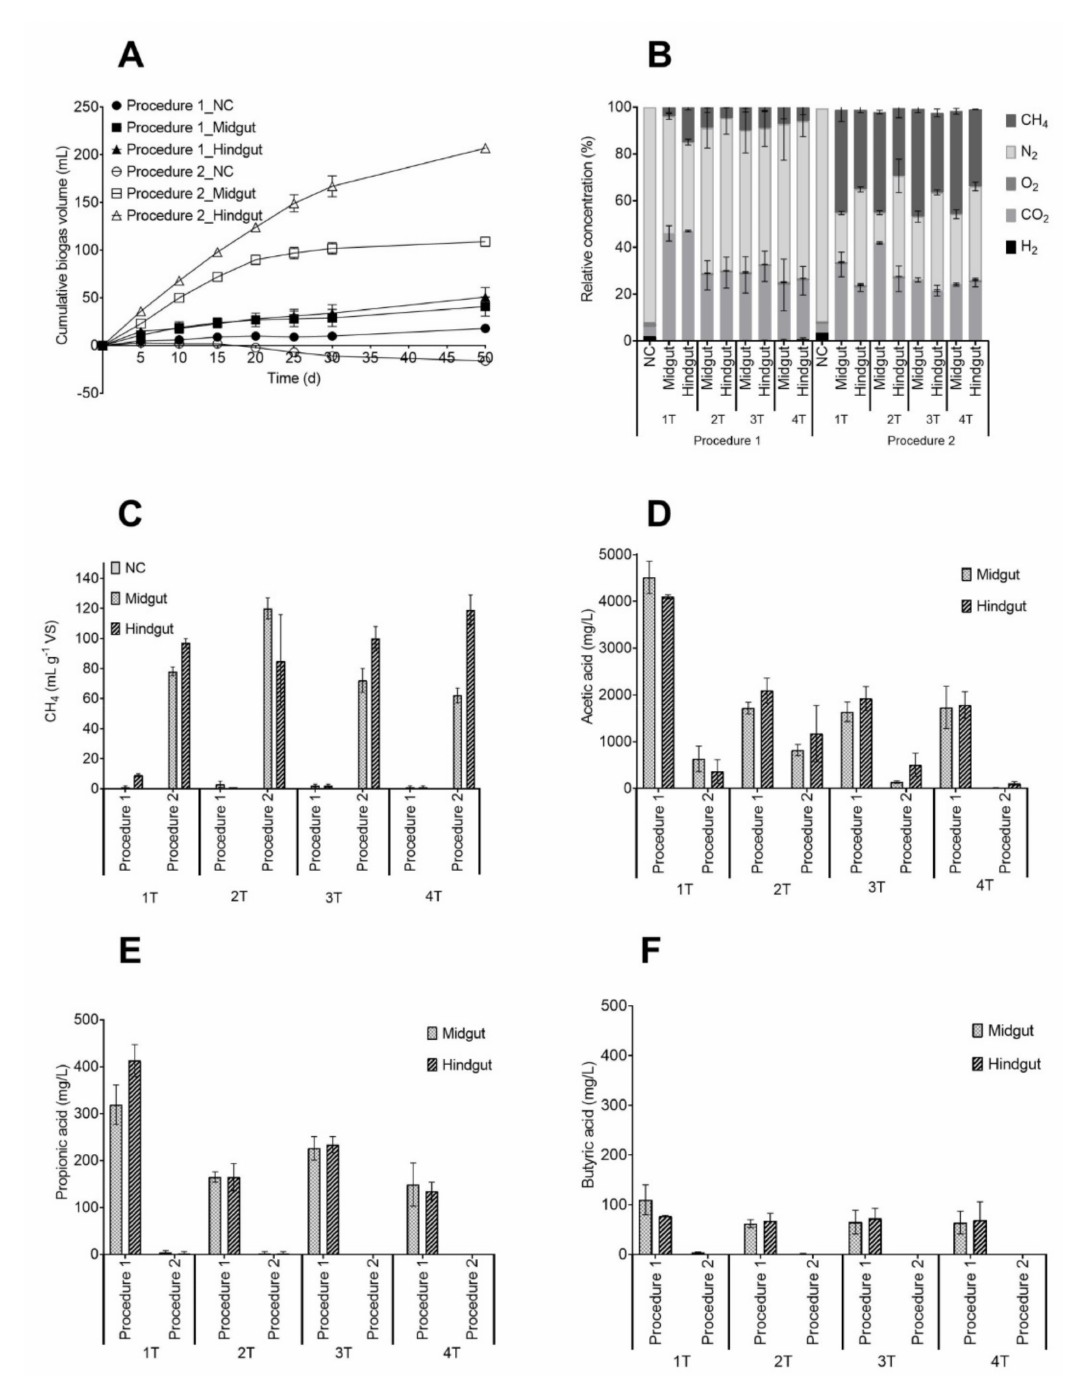
Figure 1. Physiological data of the enrichment cultures from the midgut and hindgut larva compart- ments using two different inoculum preparation procedures. ( A ) Cumulative gas over 50 days of cultivation in midgut and hindgut cultures during the fourth transfer (4T). ( B ) Relative gas concen- tration at 30 days of cultivation. ( C ) Methane yield at 30 days of cultivation. ( D – F ) Volatile fatty acids concentration at 30 days of cultivation. ( D ) Acetic acid, ( E ) propionic acid, ( F ) butyric acid concentrations. The error bars represent the standard deviation of the mean of n = 3 (invisible error bars are smaller than the symbol). Filled symbols: procedure 1. Open symbols: procedure 2. NC stands for negative